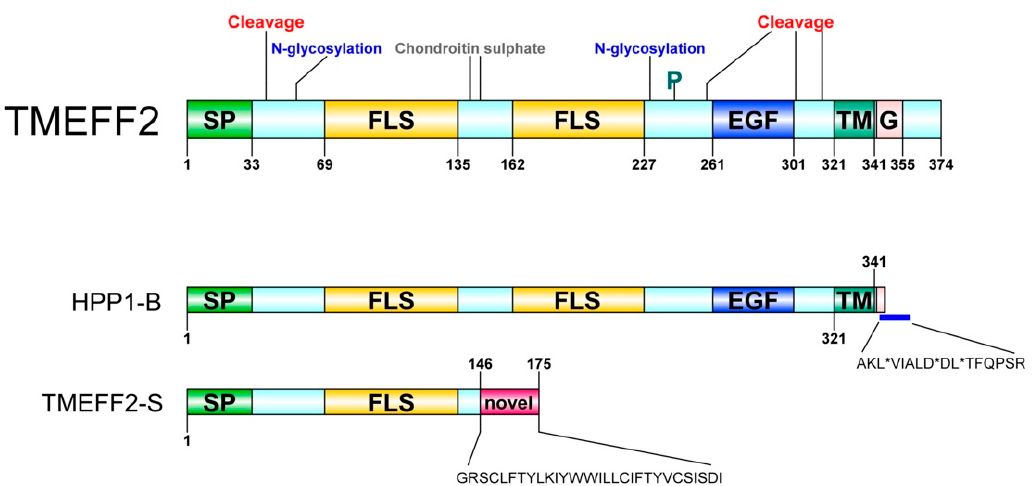
Figure 1. Transmembrane protein with an EGF-like and two Follistatin-like domains 2 (TMEFF2) protein architecture. SP: signal peptide, FLS: follistatin-like domain, EGF: EGF-like domain, TM: transmembrane domain, G: G-protein activating motif, P: phosphorylation site. A Ser/Gly rich region between the two follistatin-like domains constitutes a glycosaminoglycans (chondroitin sulphate) attachment site. A potential Tyr kinase phosphorylation site at residue 242, N-linked glycosylation sites around residues 55 and 203, and several potential protease cleavage sites (only shown cleavage sites reported through hydropathy analysis) are represented. HPP1-B is a less frequently isolated TMEFF2 variant originating from a 57-bp sequence insertion in its gene. The new sequence following the transmembrane domain contains three stop codons resulting in a truncated protein short of its cytoplasmic tail; stop sites are marked with *. TMEFF2-S is a short isoform where the first 146 residues of TMEFF2 are followed by a 29-residue long novel sequence. Imaging software: DOG [9].